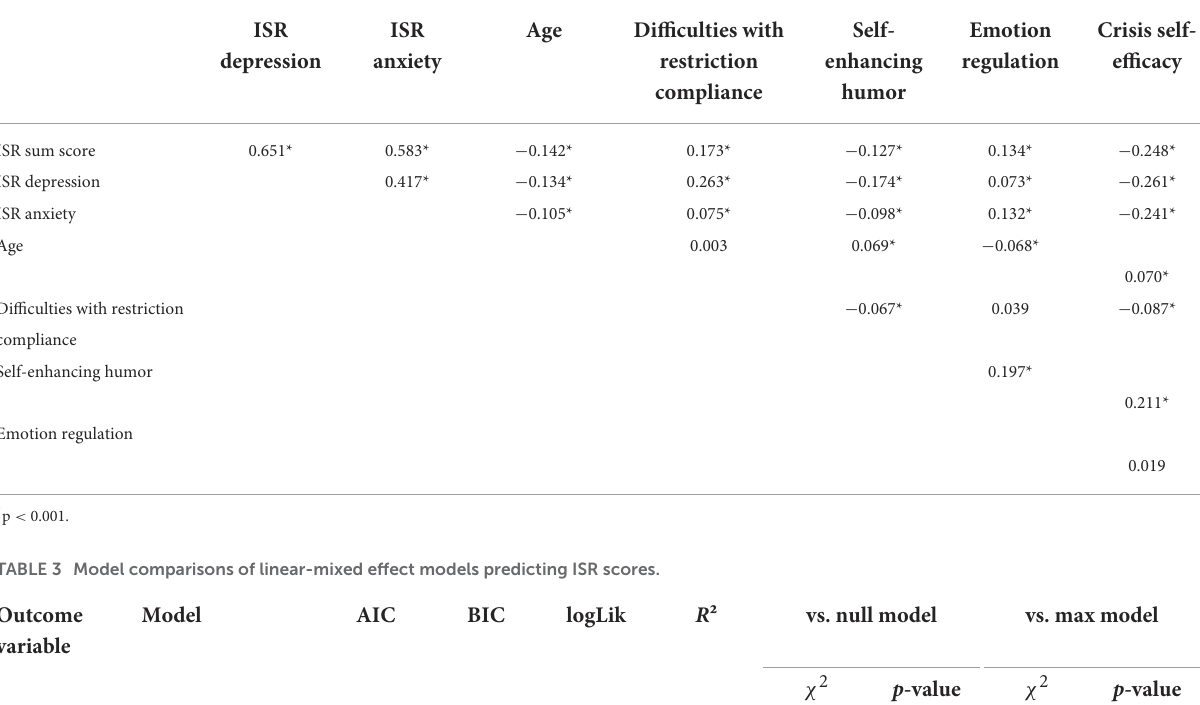
TABLE 2 Correlations between LME variables.